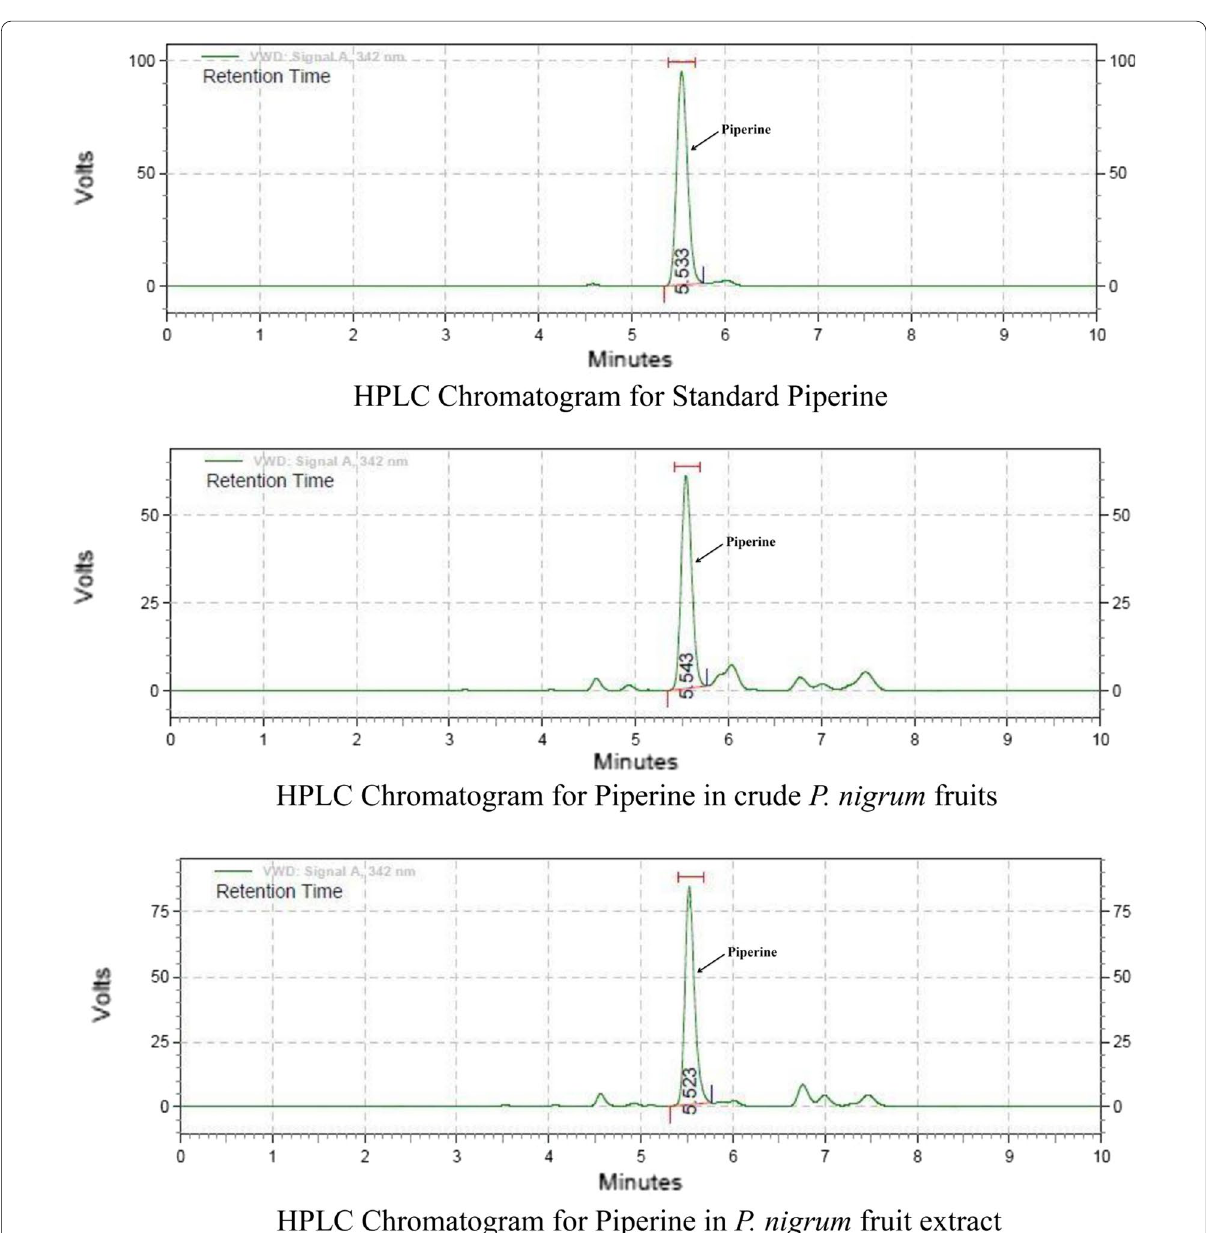
Fig. 4 HPLC chromatograms for standard Piperine, crude P. nigrum L. fruits and